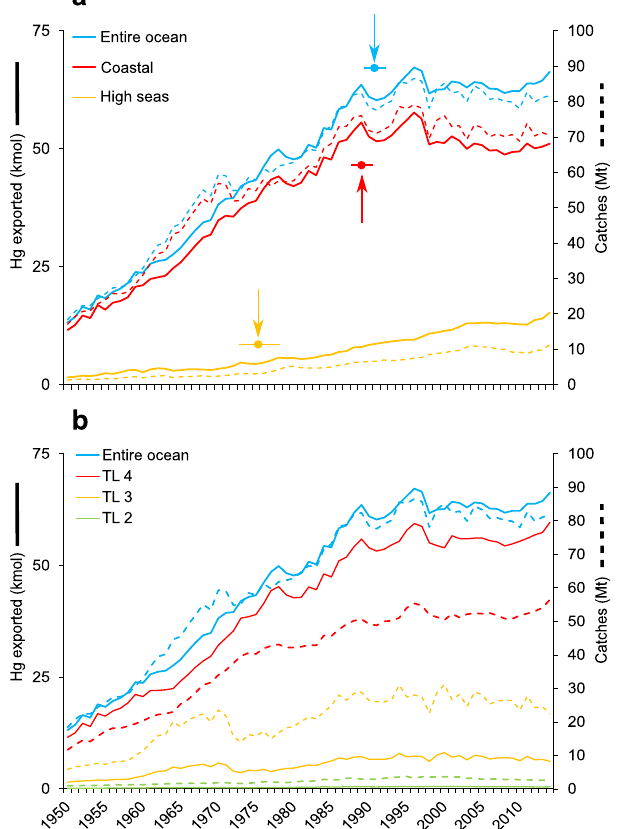
Figure 1. Temporal trends (1950 ‒ 2014) of marine fisheries catches (dashed lines) and mercury exported (full lines). ( a ) Entire ocean (blue) and coastal (red) and high seas (orange) with breakpoint (circle) ± standard error (horizontal line). See Supplementary Table 1 for results of the segmented regressions. ( b ) Entire ocean (blue) and trophic levels (TL) rounded to the nearest integer: 4 (red), 3 (orange), and 2